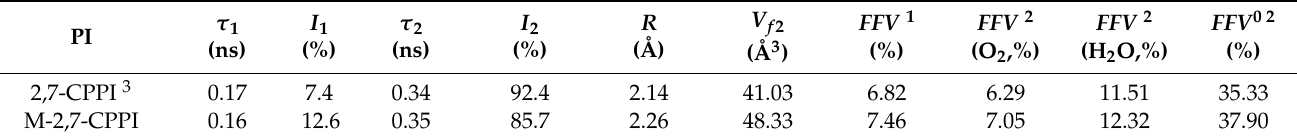
Figure 7. Positron lifetime spectra measured for the M-2,7-CPPI and 2,7-CPPI films. Table 4. The analyzed data for the positron lifetime in the M-2,7-CPPI and 2,7-CPPI films.